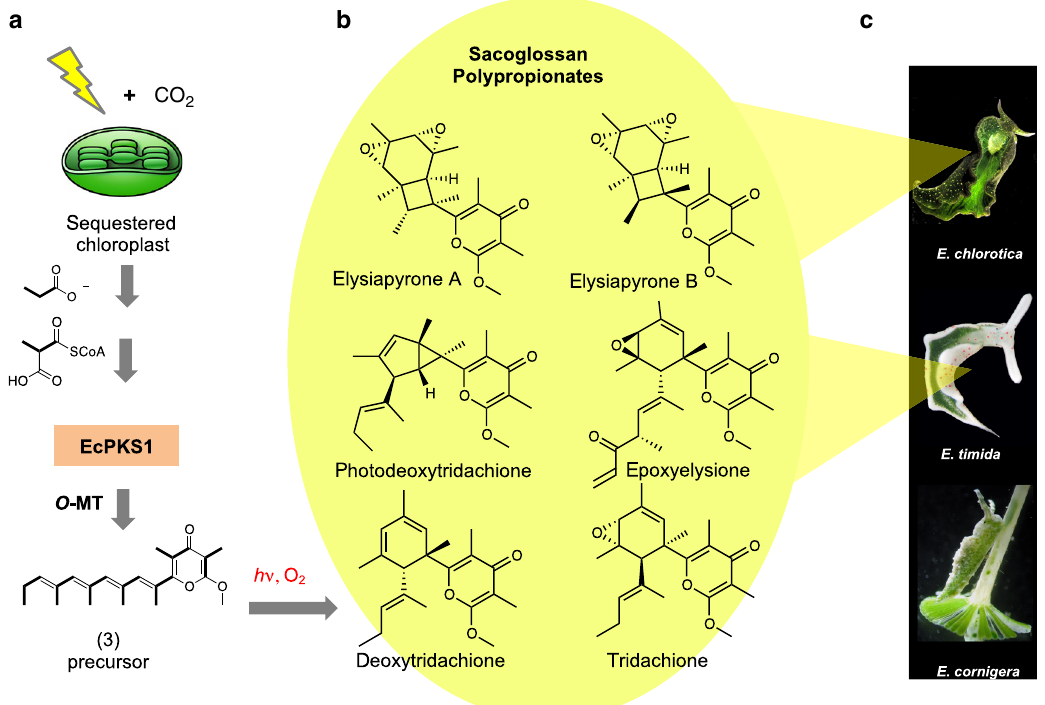
Fig. 1 Biogenesis of sacoglossan polypropionates. a Previous feeding studies demonstrated that kleptoplasts in the sacoglossans fi x carbon that is used to make polypropionates. Propionate is also a precursor, presumably via methylmalonate. A further series of hypothetical steps, including synthesis by a PKS, methylation, and photochemical and oxidation reactions would lead to b the known natural polypropionates of diverse structures. These are found in c sacoglossan species investigated in this work, including E. chlorotica and E. timida , but not E. cornigera . Photos of E. chlorotica and E. cornigera by Patrick Krug; E. timida by Heike Wägele; used with